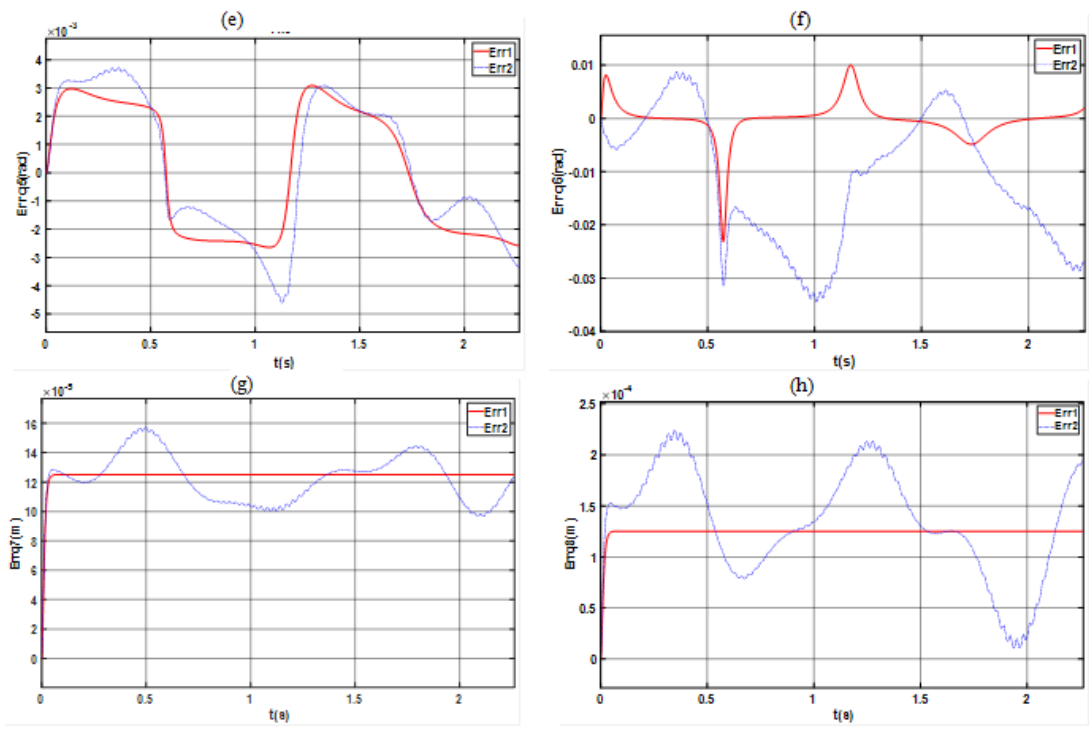
Figure 11. The errors of the joint positions of the PD1, PD2 controllers.